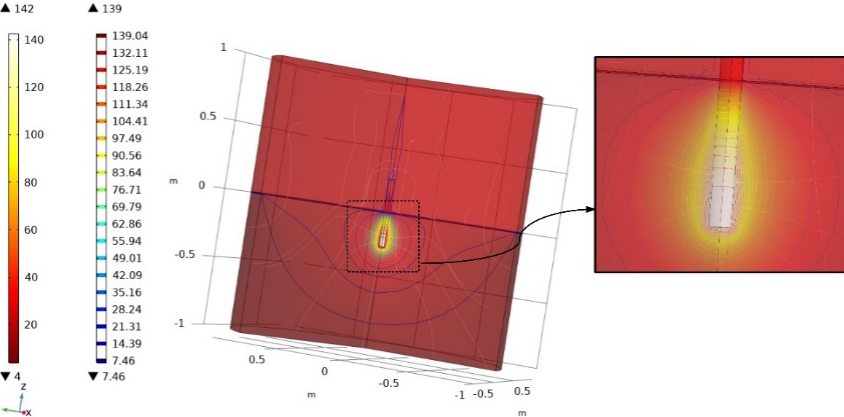
Figure 7. 12 h temperature field simulation results.